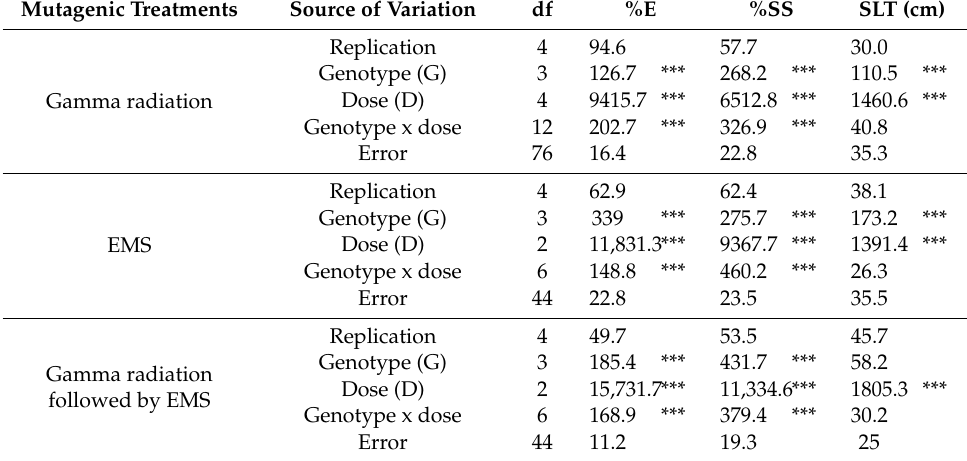
Table 1. Mean-square values and significance tests for emergence percentage (%E), seedling survival percentage (%SS) and shoot length (SLT) of four sorghum genotypes evaluated with variable doses of gamma radiation, EMS concentrations and combined treatments in Experiment